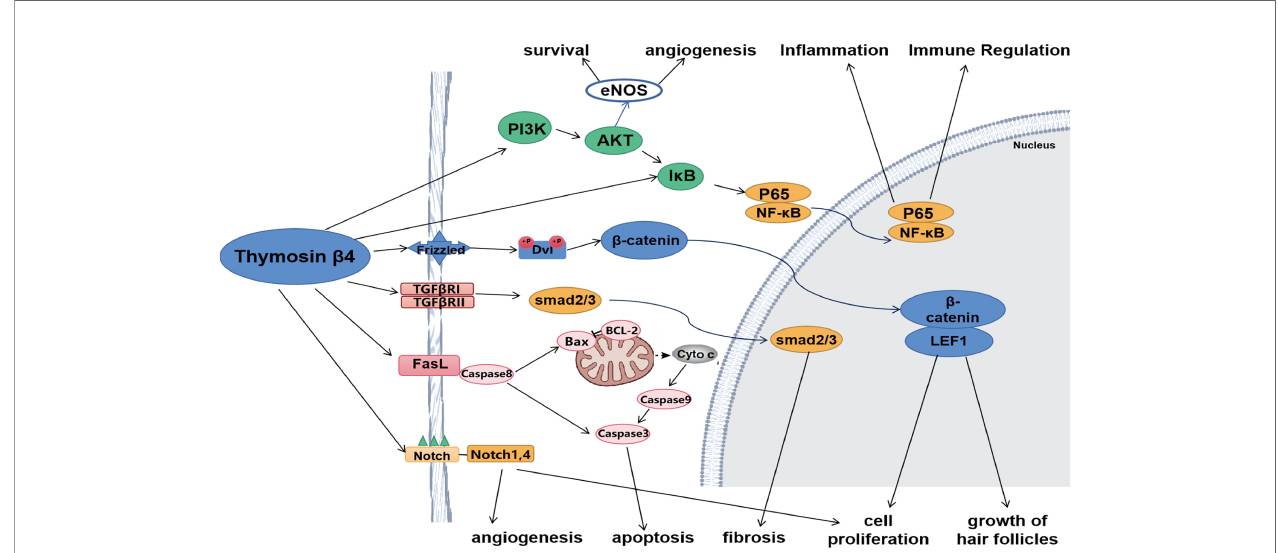
FIGURE 1 | T b 4 regulates various signaling pathways. T b 4 ameliorates in fl ammatory damage by regulating NF- k B and Toll-like receptor pathways. During tissue repair, T b 4 regulates PI3K/Akt/eNOS and Notch pathways. In addition, T b 4 regulates TGF- b pathway to alleviate fi brosis and Wnt pathway to promote hair follicle formation. T b 4 also regulates apoptosis pathway to inhibit